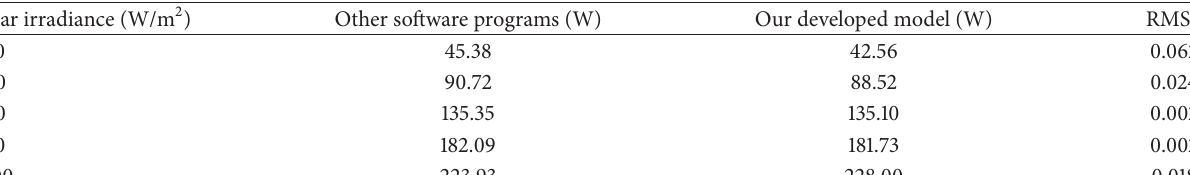
Table 4: Comparing the simulation results with other software programs by varying the solar irradiance.